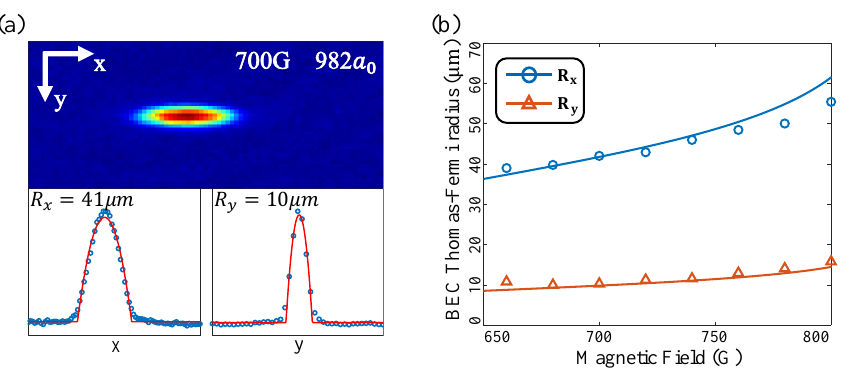
Figure 11: 1D GPE simulation demonstrates the slowing down effect due to interac- tion. The simulation is performed with a lattice potential depth of 50 E parameter r is found to monotonically increase with in interaction strength and is approximately proportional to the chemical potential for weak interaction.